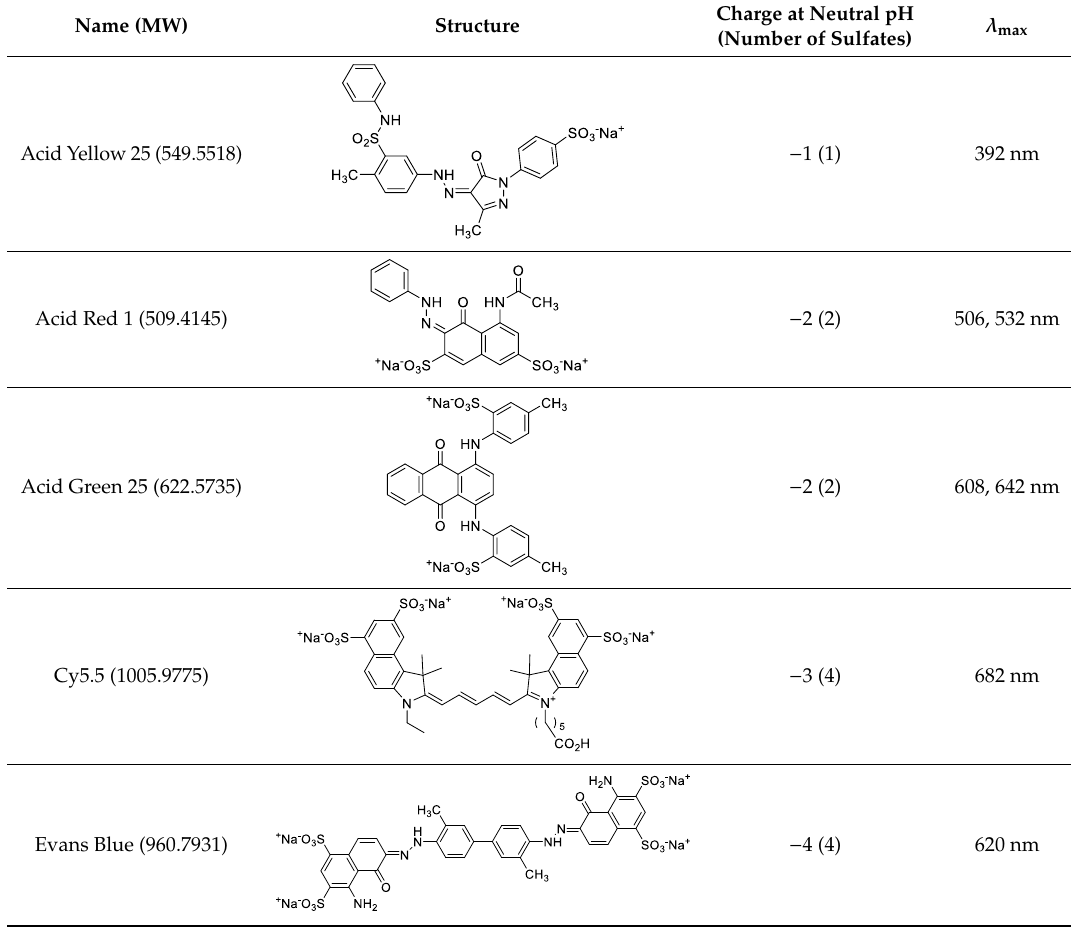
Table 2. Chemical structures and selected properties of anionic dyes.